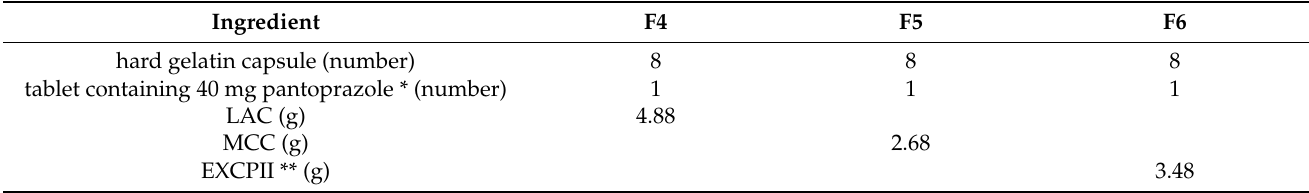
Table 2. Composition of compounded pantoprazole capsules for eight